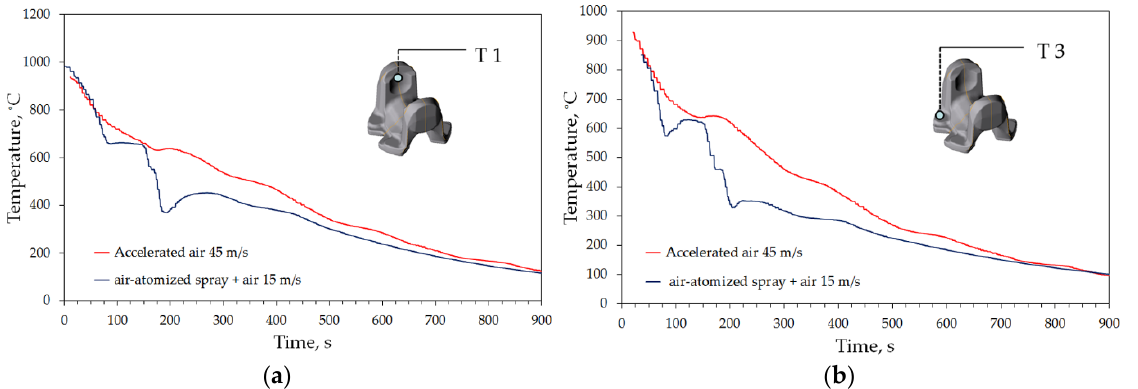
Figure 14. Comparison of the cooling curves of air and spray in locations: ( a ) T1 and ( b ) T3 (see Figure 1c).